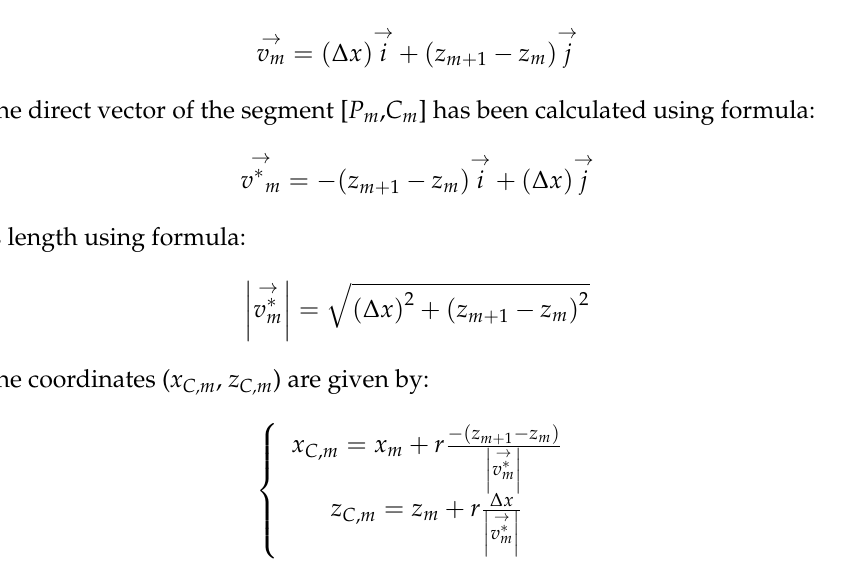
Figure 4. Representing the direct vectors.